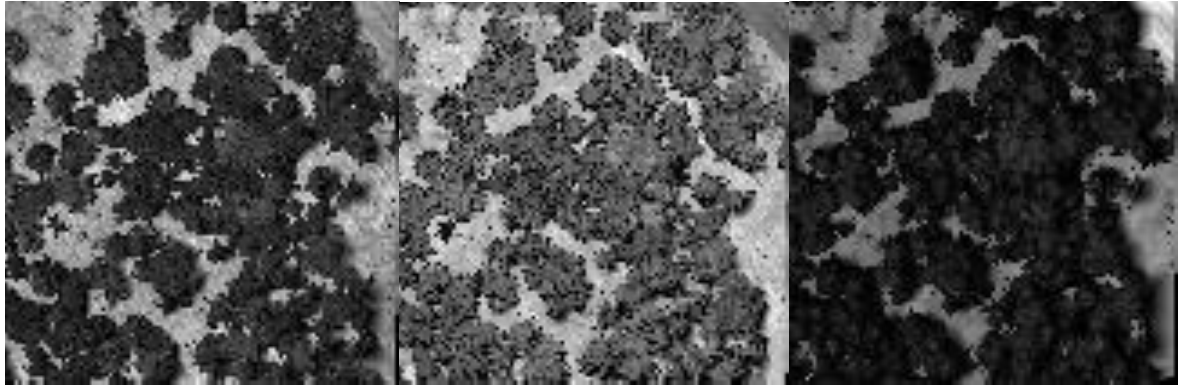
Figure 9. Calibrated intensity maps for the same plot using channel 1, channel 2 and channel 3. The beam size in channel 3 is bigger than in the other channels.